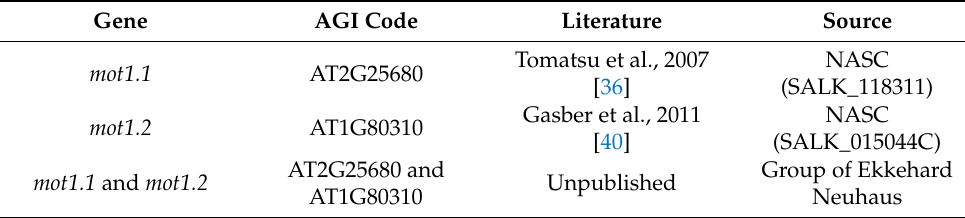
Table 1. Used KO plant lines with specification of AGI code, the literature and the source.